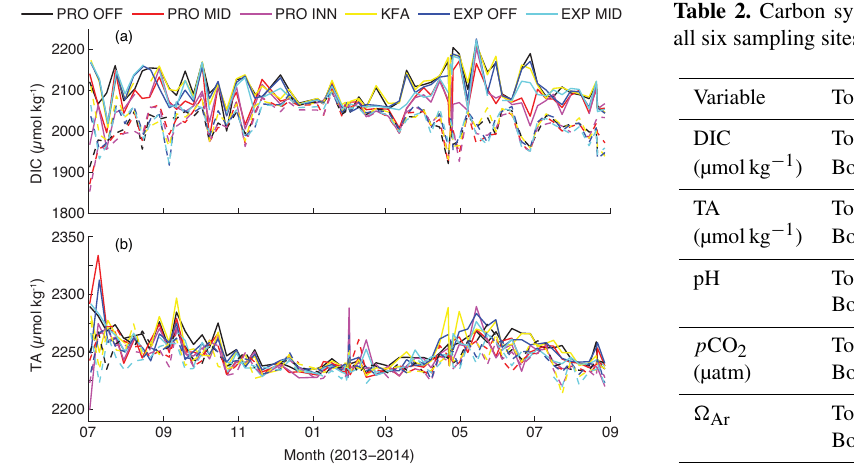
Figure 4. Time series of (a) DIC and (b) TA. Solid lines are bottom samples and dashed lines are surface samples.